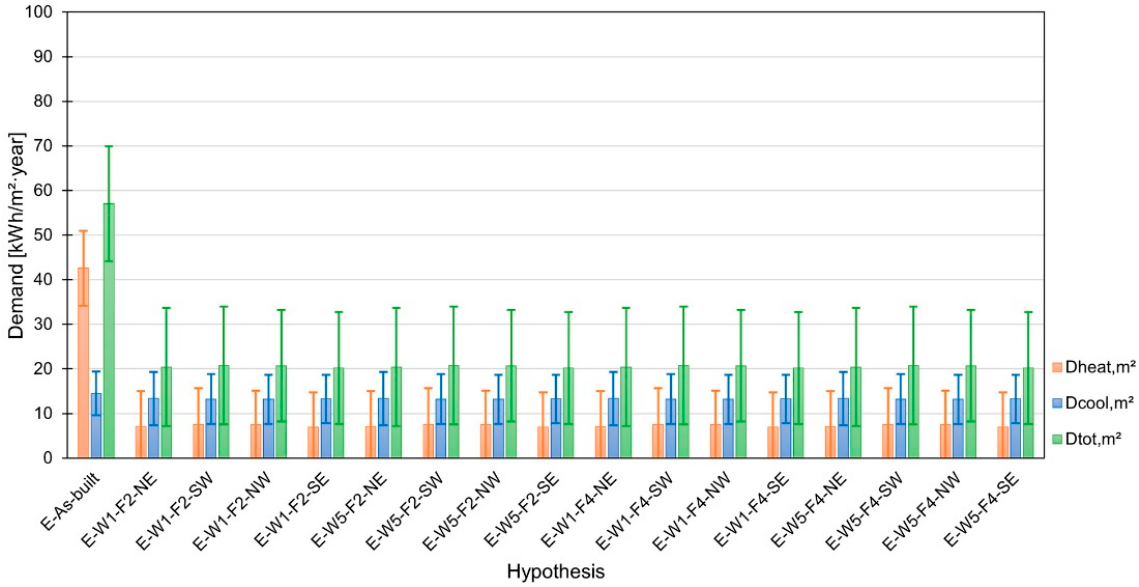
Figure 16. Combination of E-RPs. Annual average thermal demand values per m2 according to the orientation of the optimised solutions.